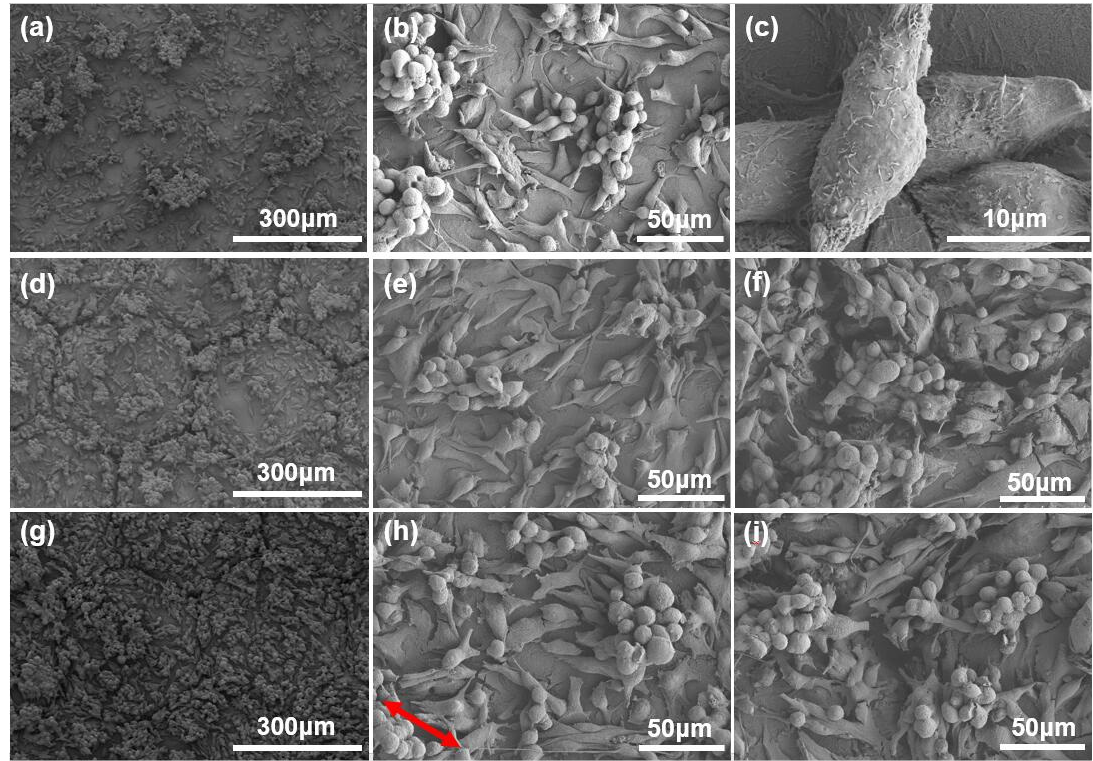
Figure 6. ( a ) SEM image of osteoblastic MC3T3-E1 cells grown on Ti-6Al-4V samples with smooth surface after cultivation for 7 days. ( b ) The enlarged view of ( a ). ( c ) The enlarged view of osteoblastic MC3T3-E1 cells in ( a ). ( d ) SEM image of osteoblastic MC3T3-E1 cells grown on Ti-6Al-4V samples with the array of micro-hexagons at a hexagon side length of 200 μ m after cultivation for 7 days. ( e ) The enlarged view of ( d ) in the area within the micro-hexagon. ( f ) The enlarged view of ( d ) in the area near the channels between micro-hexagons. ( g ) SEM image of osteoblastic MC3T3-E1 cells grown on Ti-6Al-4V samples with composite micro/nano-structures at a hexagon side length of 200 μ m after cultivation for 7 days. ( h ) The enlarged view of ( g ) in the area within the micro-hexagon (the arrow indicates the orientation of nano-ripples). ( i ) The enlarged view of ( g ) in the area near the channels between